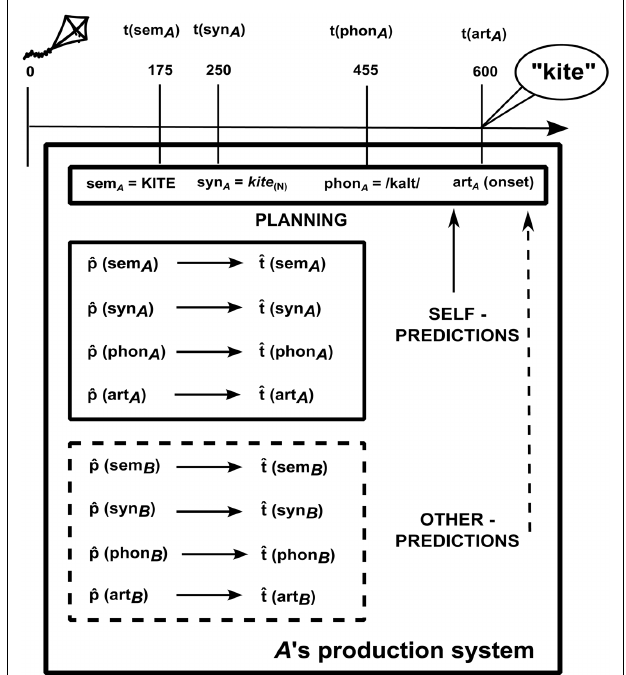
FIGURE 1 | Simultaneous production. A produces the word kite in response to the picture of a kite. sem A , syn A , phon A are semantic, syntactic, and phonological representations for A ’s utterance. t(sem A ), t(syn A ), t(phon A ) indicate the actual time elapsed from picture onset (in ms) when processing is completed at each stage and the corresponding representation has been built (based on Indefrey and Levelt, 2004); t(art A ) marks the onset of A ’s utterance. ˆ t (sem A ), ˆ t (syn A ), ˆ t (phon A ), and ˆ t (art A ) are timing estimates computed by A for her own utterance. ˆ p (sem A ), ˆ p (syn A ), ˆ p (phon ˆ p (art A ), A ) are the content predictions for A ’s own utterance, on which the timing estimates are based. A believes that B is speaking in response to the same picture. Dotted lines refer to representations of the other. ˆ t (sem B ), ˆ t (syn B ), ˆ t (phon B ), and ˆ t (art B ) are timing estimates computed by A for B ’s utterance. ˆ p (sem B ), ˆ p (syn B ), ˆ p (phon B ), ˆ p (art B ) are A ’s content predictions, at the various processing stages, for B ’s utterance. Horizontal arrows [from ˆ p (sem A ) to ˆ t (sem A ), from ˆ p (syn A ) to ˆ t (syn A ), etc.] indicate that estimates of the timing at each level are based on content predictions at the same level.Timing estimates at one level could also be directly based on content estimates at other levels, but we ignore this here for simplicity.Vertical arrows from self- and other-predictions to planning represent the integration stage.